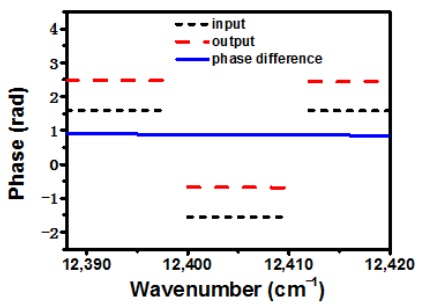
Figure 13. Schematic of the phases of the input, response, and the phase difference of ( a ) pump and ( b ) probe pulse.